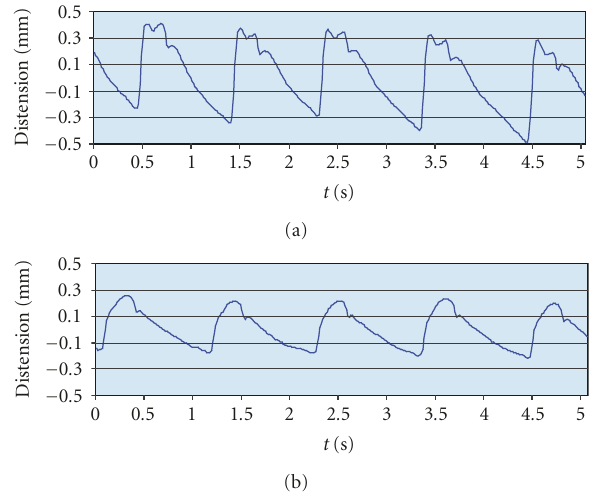
Figure 8: Distension waveforms measured in the carotid artery of two volunteers aged 31 (a) and 65 (b) featuring a distensibility of, respectively, 10% and